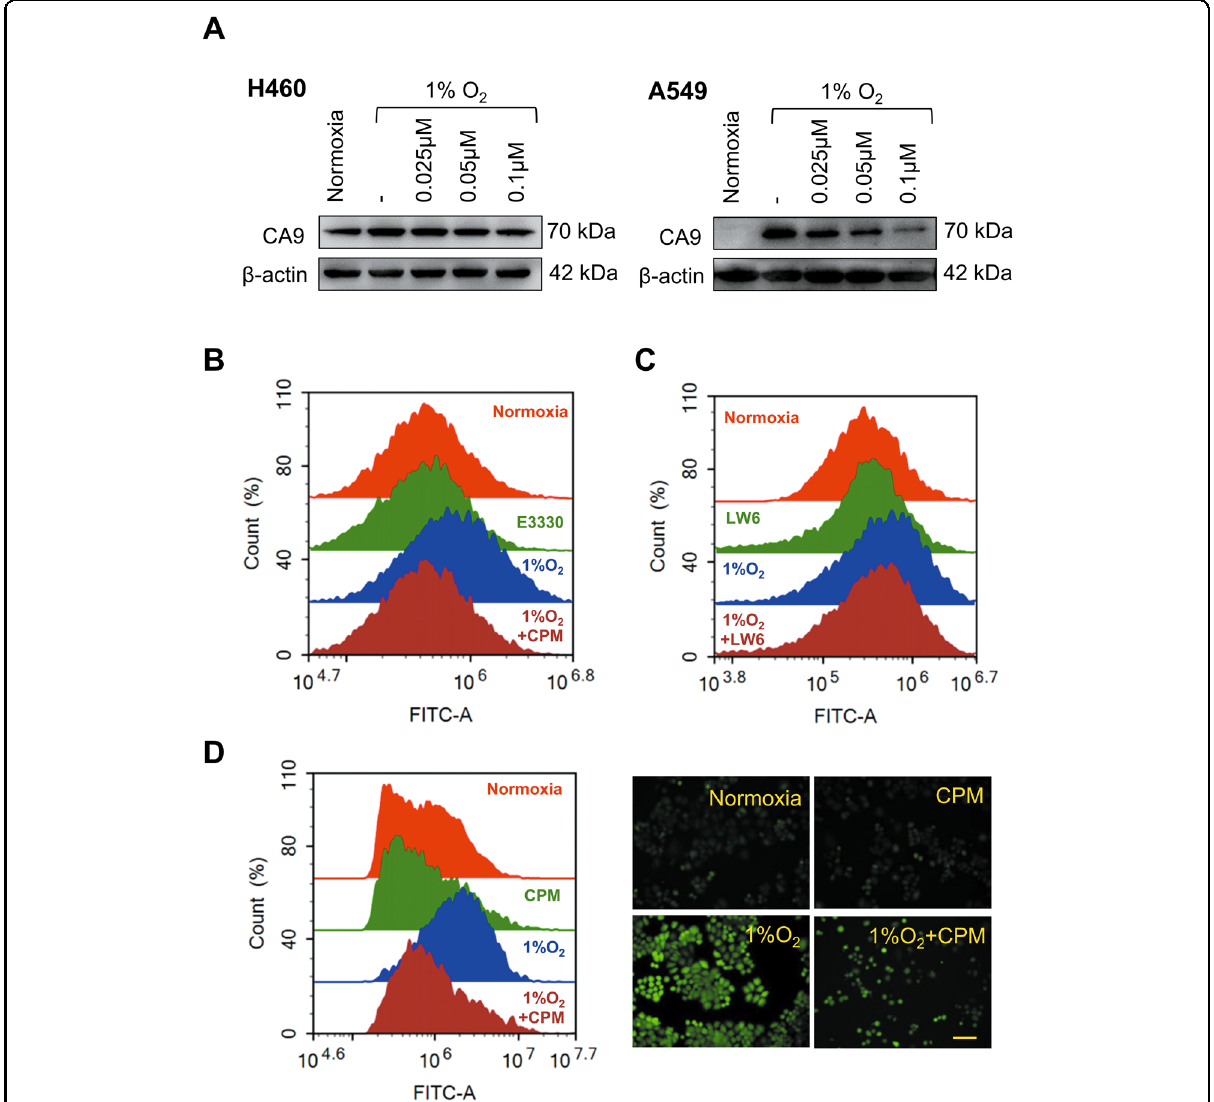
Fig. 4 CPM could acidify intracellular pH in LC cells during hypoxia. A Western blot analysis of CA9 expression at various concentrations treated with CPM. B Intracellular pH determination of H460 cell line treated with APEX1 inhibitor E3330 under normoxia and hypoxia using fl ow cytometry. C Intracellular pH determination of H460 cells line treated with LW6 under normoxia and hypoxia using fl ow cytometry. D Intracellular pH determination of H460 cell line-treated CPM under normoxia and hypoxia using fl ow cytometry, using BCECF-AM dye for staining in H460 cells, images taken by a fl uorescence